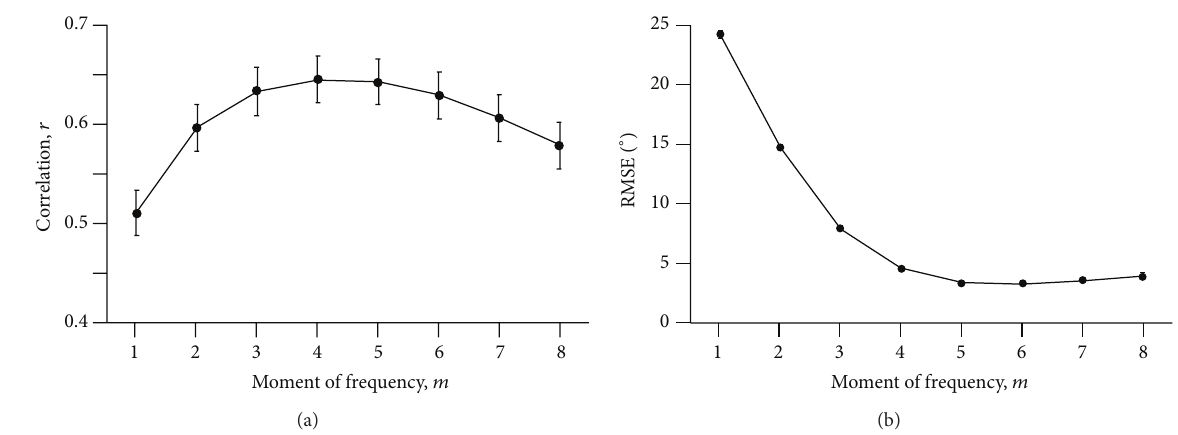
Figure 3: Error Analysis for the Selection of the Moment of Frequency , 𝑚 . The correlation between the inclination angle determined by manual digitization, 𝜃 𝑑 , and the inclination angle determined from the discrete Fourier transform, 𝜃 𝐹 , is shown for different values of 𝑚 (a). The root-mean-square error between these terms is shown in (b). Points show the mean ± SEM ( 𝑛 = 99 ).